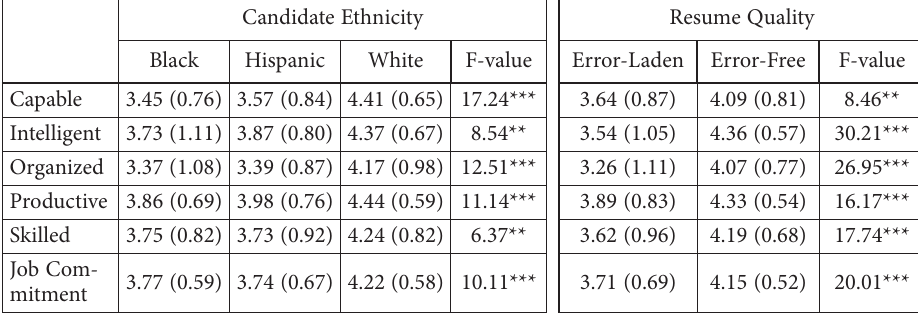
Table 2. Means and (standard deviations) of candidate ethnicity and resume quality for the six candi- date traits Candidate Ethnicity Resume Quality